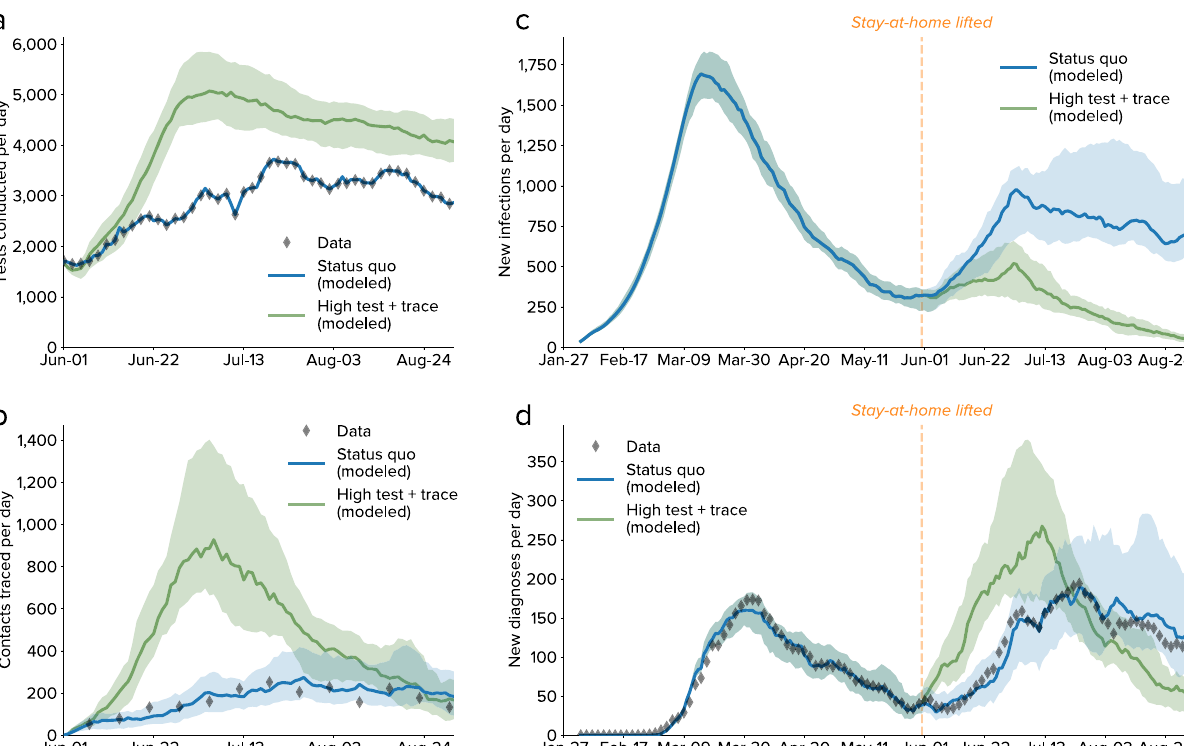
Fig. 5 Comparison between observed epidemic trends and projected scenarios from 1 June to 31 August 2020. a Number of tests conducted per day, with modeled values for the status quo (using the data as an input) and a counterfactual scenario with high testing and high tracing. b Number of contacts traced per day. c Estimated number of new infections, with a signi fi cant rise in infections observed shortly after the stay-at-home order was lifted. d Number of diagnoses per day, showing consistency between the model and the data both for the calibrated period (27 January – 31 May 2020) and the projected period (1 June – 31 August 2020). In all panels, lines show medians, and shaded regions show 80% con fi dence